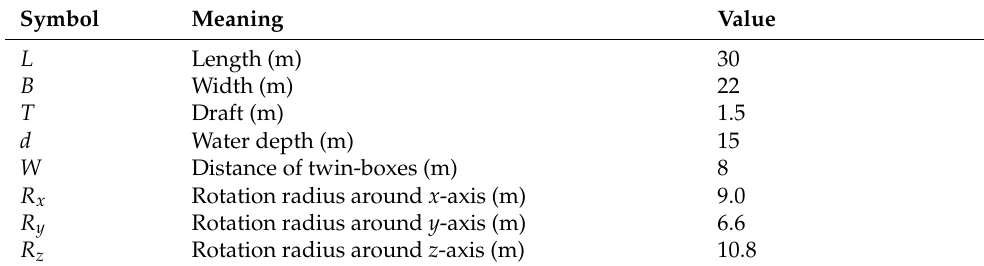
Figure 3. Sketch of the wave interaction a twin-box structure. Table 1. Parameters of the double-box